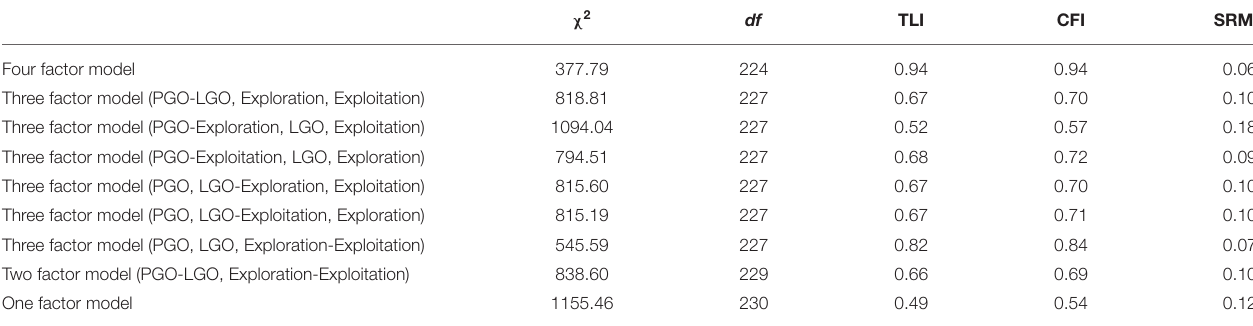
TABLE 2 | Results of confirmatory factor analysis.